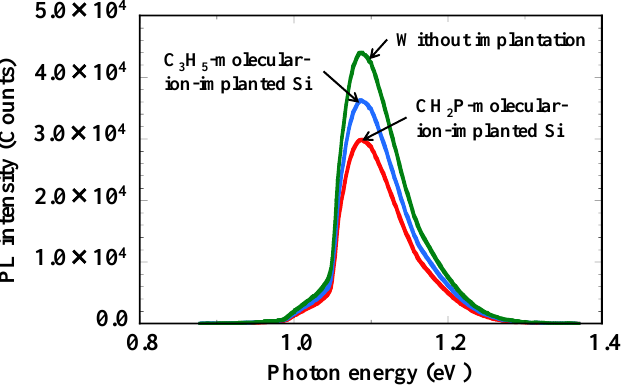
Figure 8. RTPL spectra under 827 nm excitation in epitaxial silicon wafers without and with CH 2 P- and C 3 H 5 -molecular-ion-implanted regions.